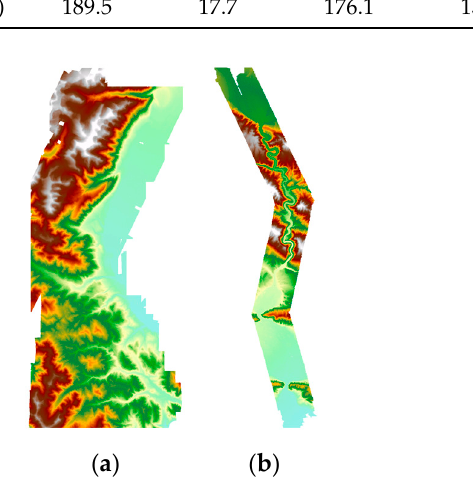
Figure 10. Raster Digital Elevation Model (DEM) interpolated by the hybrid parallel TPS algorithm. ( a ) pcd_01 ; ( b )